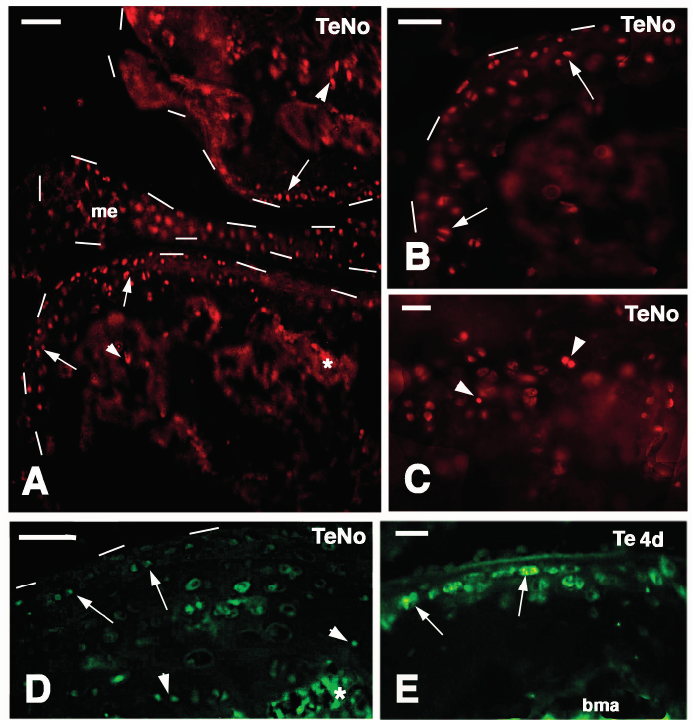
Figure 7. Immunofluorescence for a telomerase-1 components in normal knees (TeNo A – C , TRITC; D , FITC) and at four days post-injury ( E , FITC). Dashes outline the articular cartilages and meniscus surfaces. ( A ) Sparse labeled cells are seen in the articular cartilages of the femur (top arrow) and tibia (bottom arrows), and few in the metaphyses (arrowheads). Also some labeled cells are present in the meniscus. The asterisk indicates a non-specific fluorescence of the mineralized matrix. Bar, 50 µm; ( B ) detail of labeled cells (arrows) on the surface of the articular cartilage. Bar, 50 µm; ( C ) detail on labeled cells (arrowheads) in the serial cartilage of the metaphyseal growth plate. Bar, 25 µm; ( D ) other images showing labeled cells on the articular surface (arrows) and metaphyseal growth plate (arrowheads) of a normal tibia. The asterisk indicates a non-specific fluorescence of the mineralized matrix. Bar, 50 µm; ( E ) labeled cells (arrows) in an intact area of the articular cartilage of a tibia four days after injury. bma, bone marrow. Bar, 25 µm. At four days post-lesion sparse telomerase-labeled flat cells remained on the surface of the intact articular cartilage (Figure 7E) while labeled cells disappeared in the degenerating regions. In the regenerating cartilage of the epiphyses observed at seven days post-lesion, labeled cells were seen not only in the articular surface but sparse labeled cells were also present within the cartilaginous tissue in both femur and tibia (arrows and arrowheads in Figure